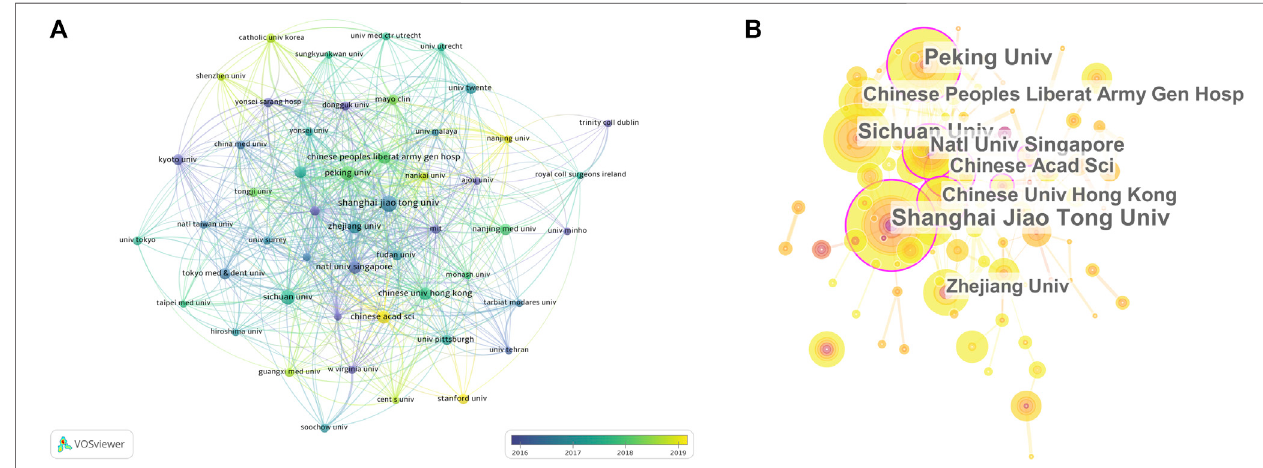
FIGURE 3 | Articles on stem cells for cartilage regeneration published at different institutions . (A) Collaboration between institutions based on VOSviewer (B) cooperation network analysis of institutions based on CiteSpace.